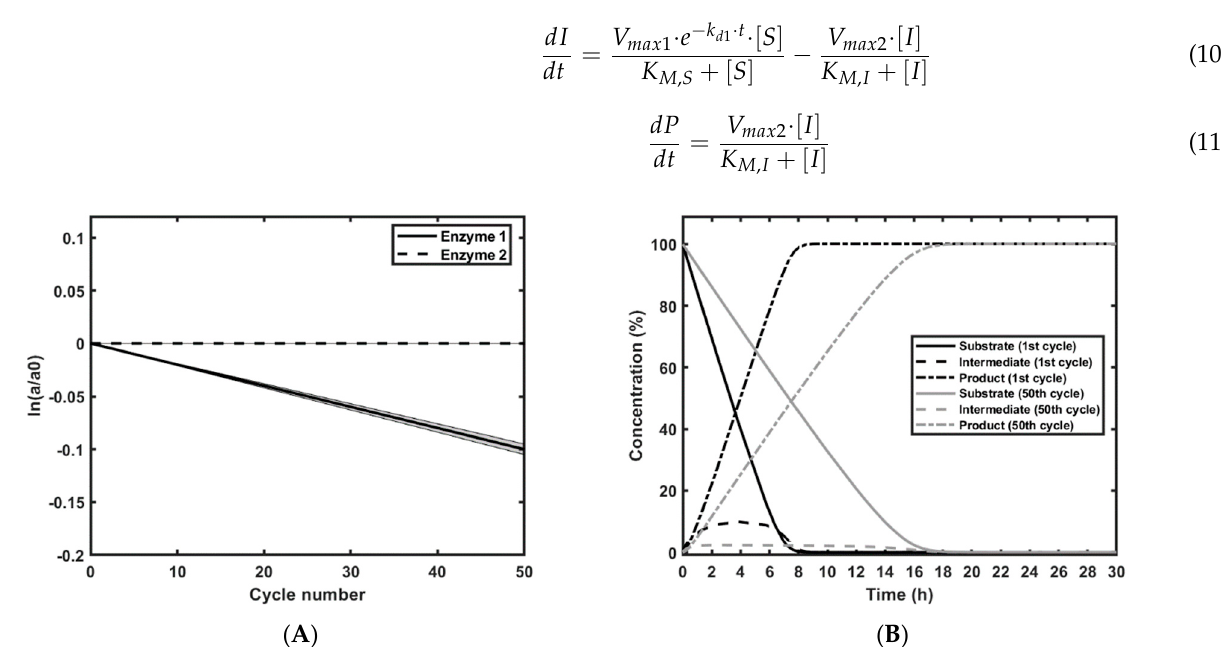
Figure 4. Enzyme 1 deactivates, while enzyme 2 remains fully active. ( A ) The deactivation is assumed to be first-order decay, with a deactivation constant of 0.002 h − 1 for both enzymes. The shaded area indicates an error of ±5%. ( B ) Simulated time course of the concentration profile. The black line shows the initial reaction cycles, and the grey lines illustrate the time course of the 50th reaction cycle in the presence of deactivation, with a deactivation constant at 0.002 h − 1 . Kinetic parameters and initial enzyme concentrations are listed in Table 1.